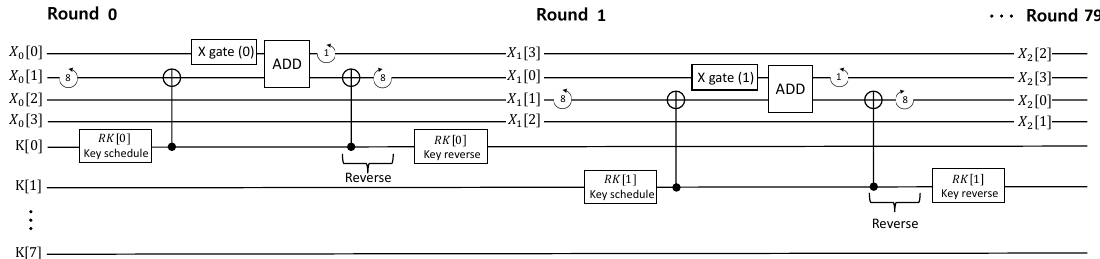
Figure 12. Quantum circuit for